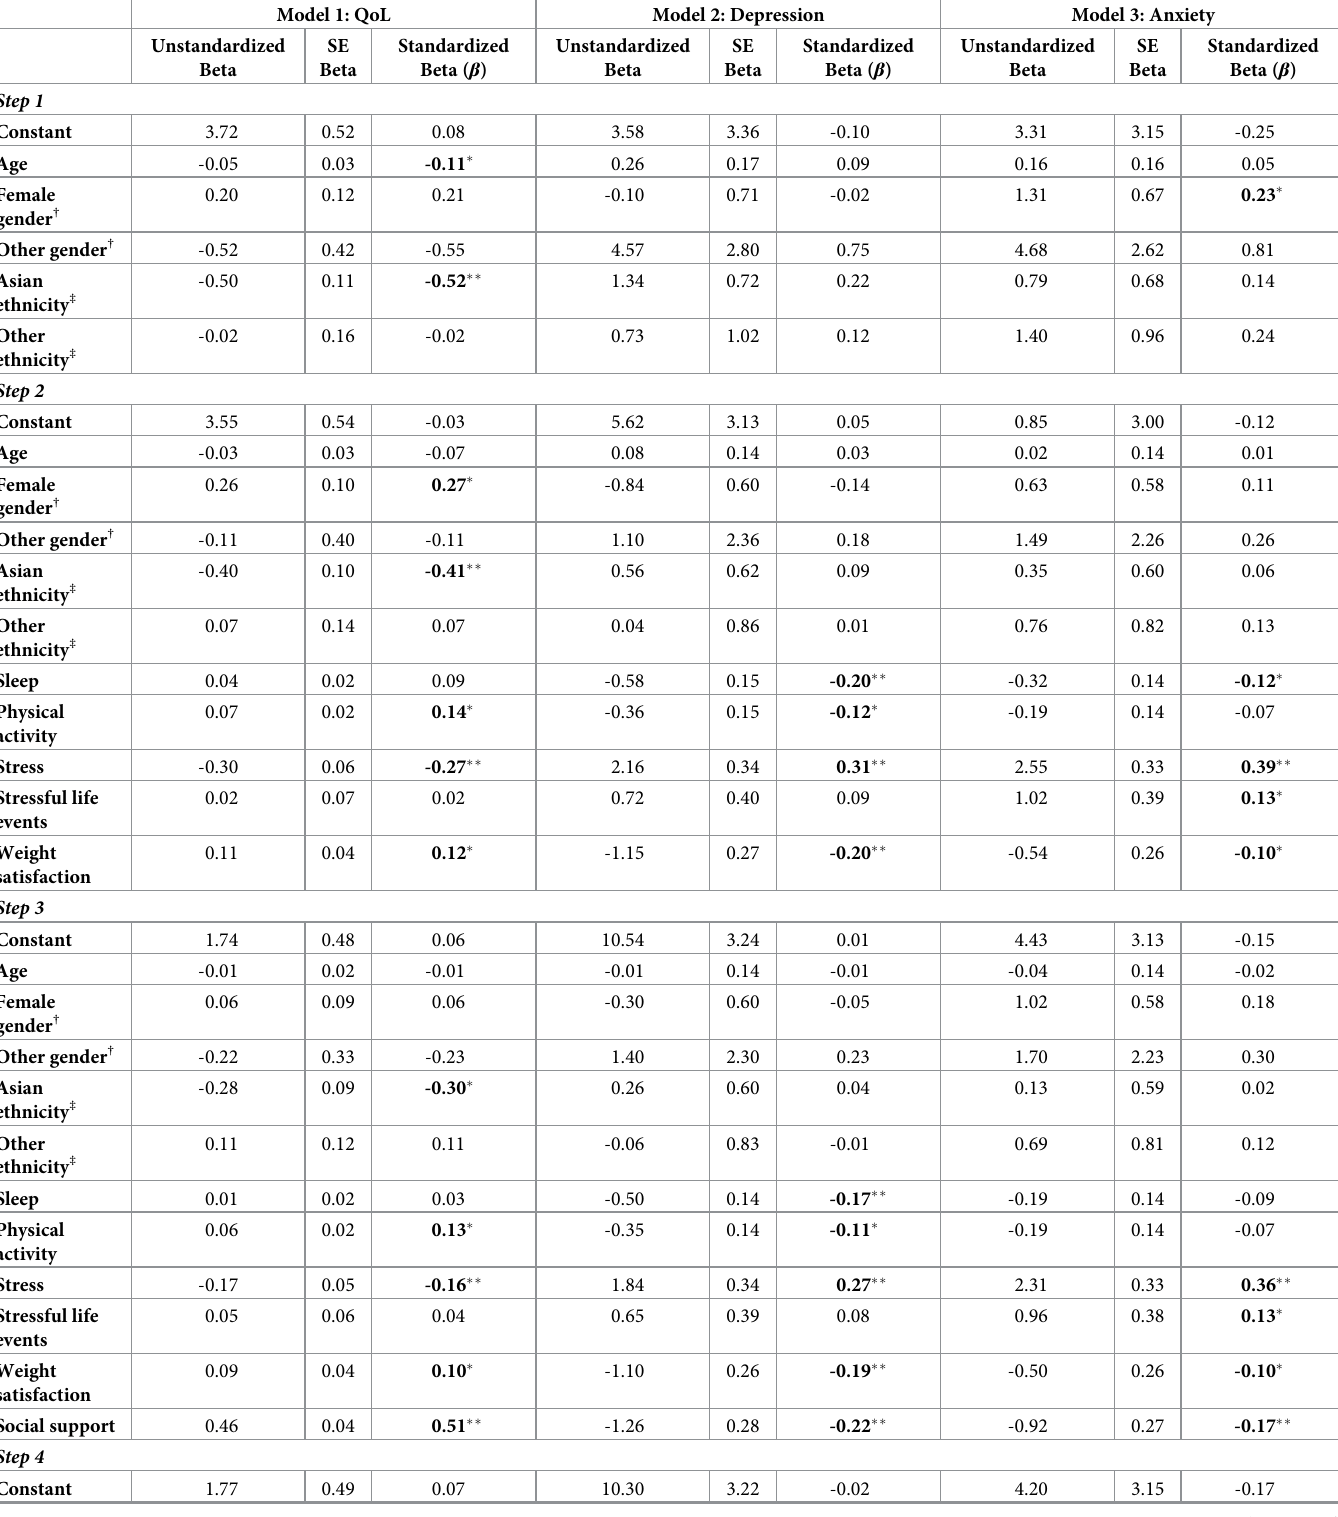
Table 6. Adjusted effects of principal component analysis (PCA) diet components on quality of life (QoL), depression, and